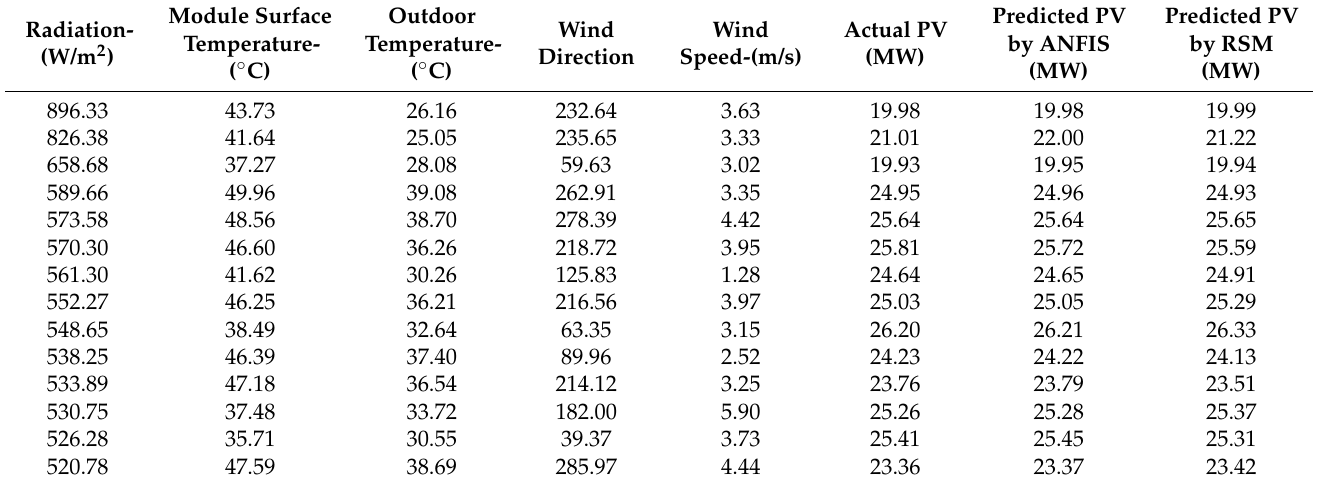
Table 2. Actual and predicted solar PV generated for certain parameters.